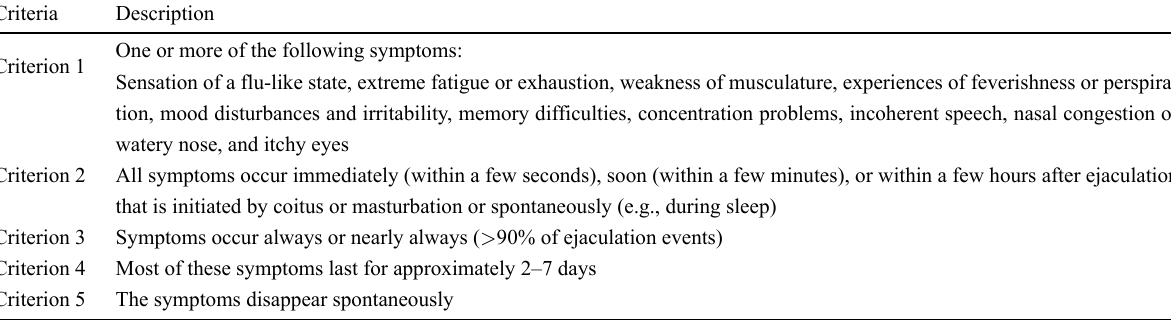
Table 1. Five preliminary diagnostic criteria of POIS [1].